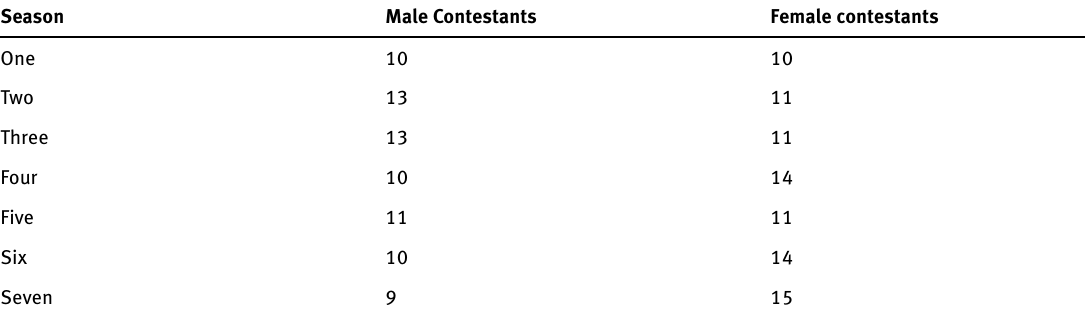
Table 1: Number of female and male contestants in MCA Season Male Contestants Female